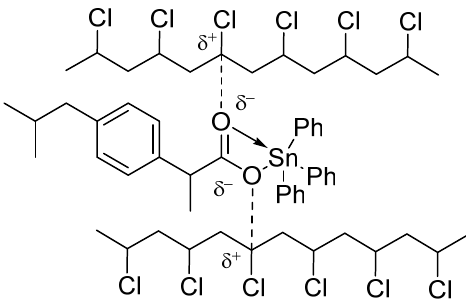
Figure 12. Organotin complexes as primary stabilizers.